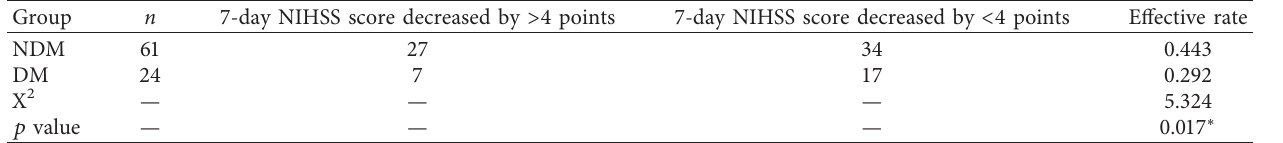
Table 4: Comparison of 7-day NIHSS scores after rtPA intravenous thrombolysis of both groups. Group